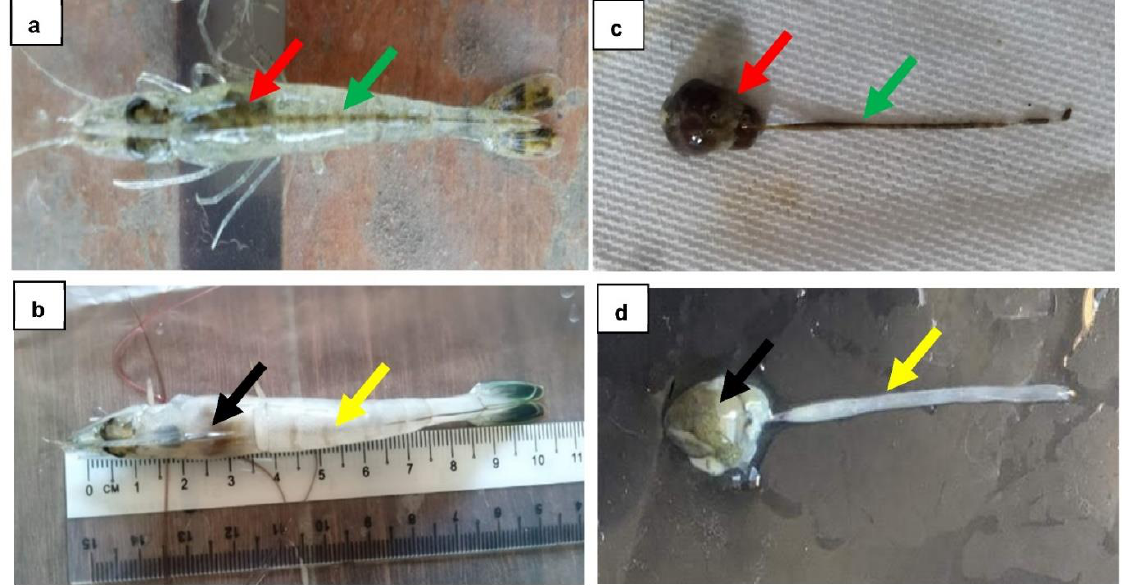
Figure 1. Gross signs between healthy and unhealthy shrimp. ( a , c ); healthy shrimp had a large pigmented hepatopancreas (red arrow) and full midgut (green arrow). ( b , d ); unhealthy shrimp had a pale, atrophied hepatopancreas (black arrow) and an empty midgut (yellow arrow). ( c , d ) are hepatopancreases individually dissected from the shrimp.